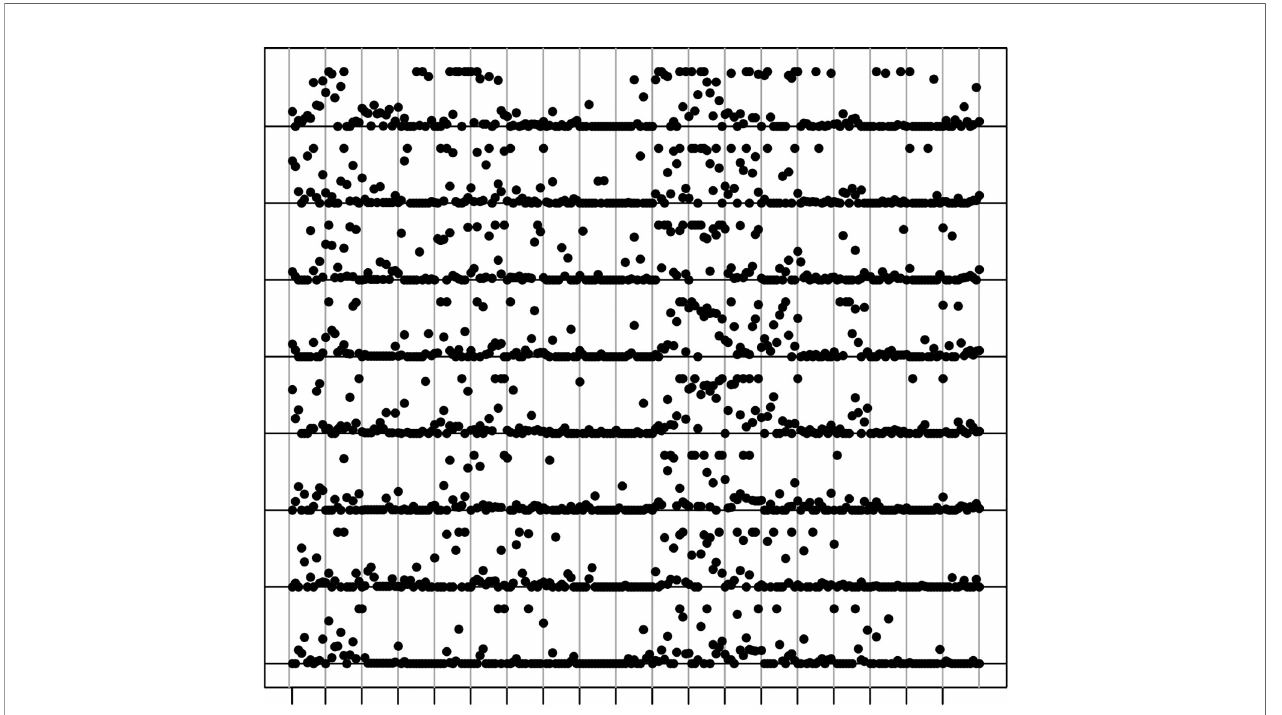
FIGURE 7 | This is the stacked curves plot for the second mutational marker found in the Leydig cell tumor. There is an additional z coordinate compared to the fi rst marker, which results in 12 × 19 = 228 samples for each of the 8 slices.